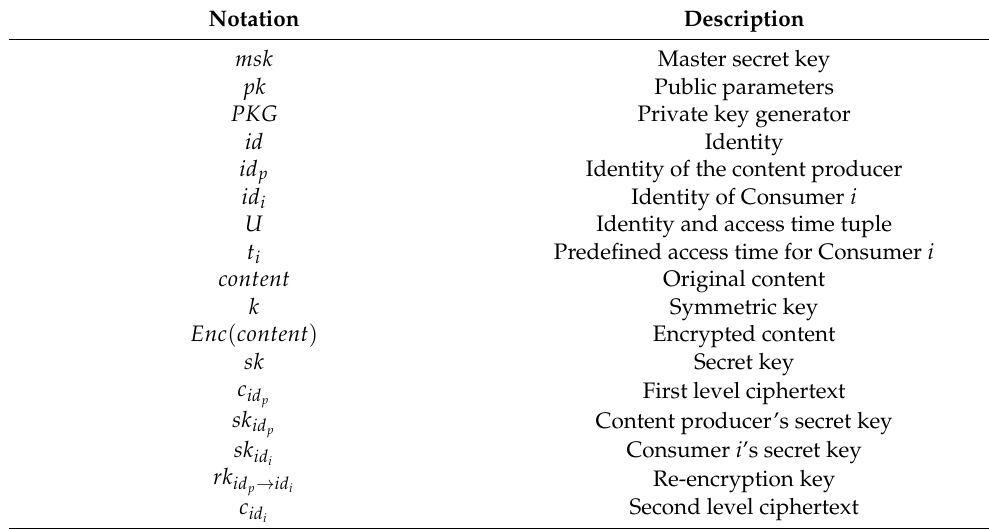
Table 1. List of notations used in our